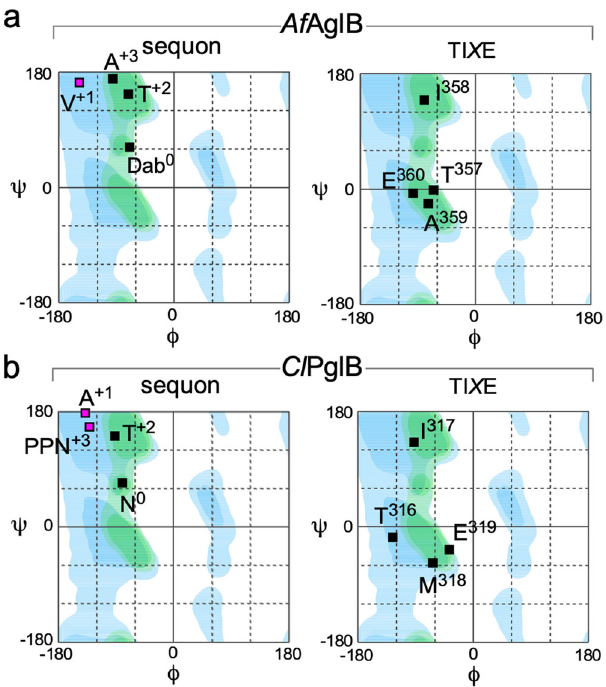
Fig. 4 Ramachandran plots ( ϕ – ψ diagrams) for the sequon segment and the TIXE motif. a Af AglB and b Cl PglB (PDB: 5OGL). The favored and allowed regions for 19 amino acids are deep and pale blue, respectively, and the favored and allowed regions for proline are deep and pale green, respectively. PDB: 5OGL was used in consideration of its higher resolution (2.7 Å) than PDB: 6GXC (3.4